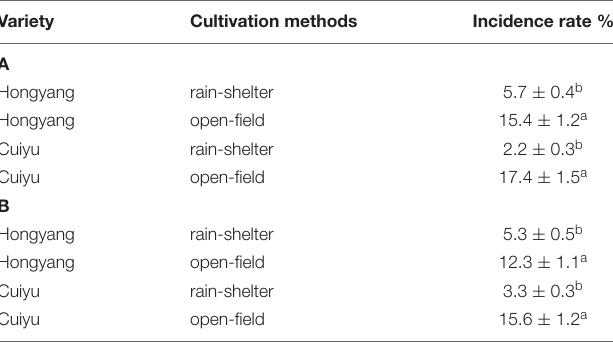
TABLE 1 | Pre-harvest incidence of natural disease in “Hongyang” and “Cuiyu” kiwifruit cultivars in 2018 (A) and 2019 (B) grown under rain-shelter and open-field cultivation